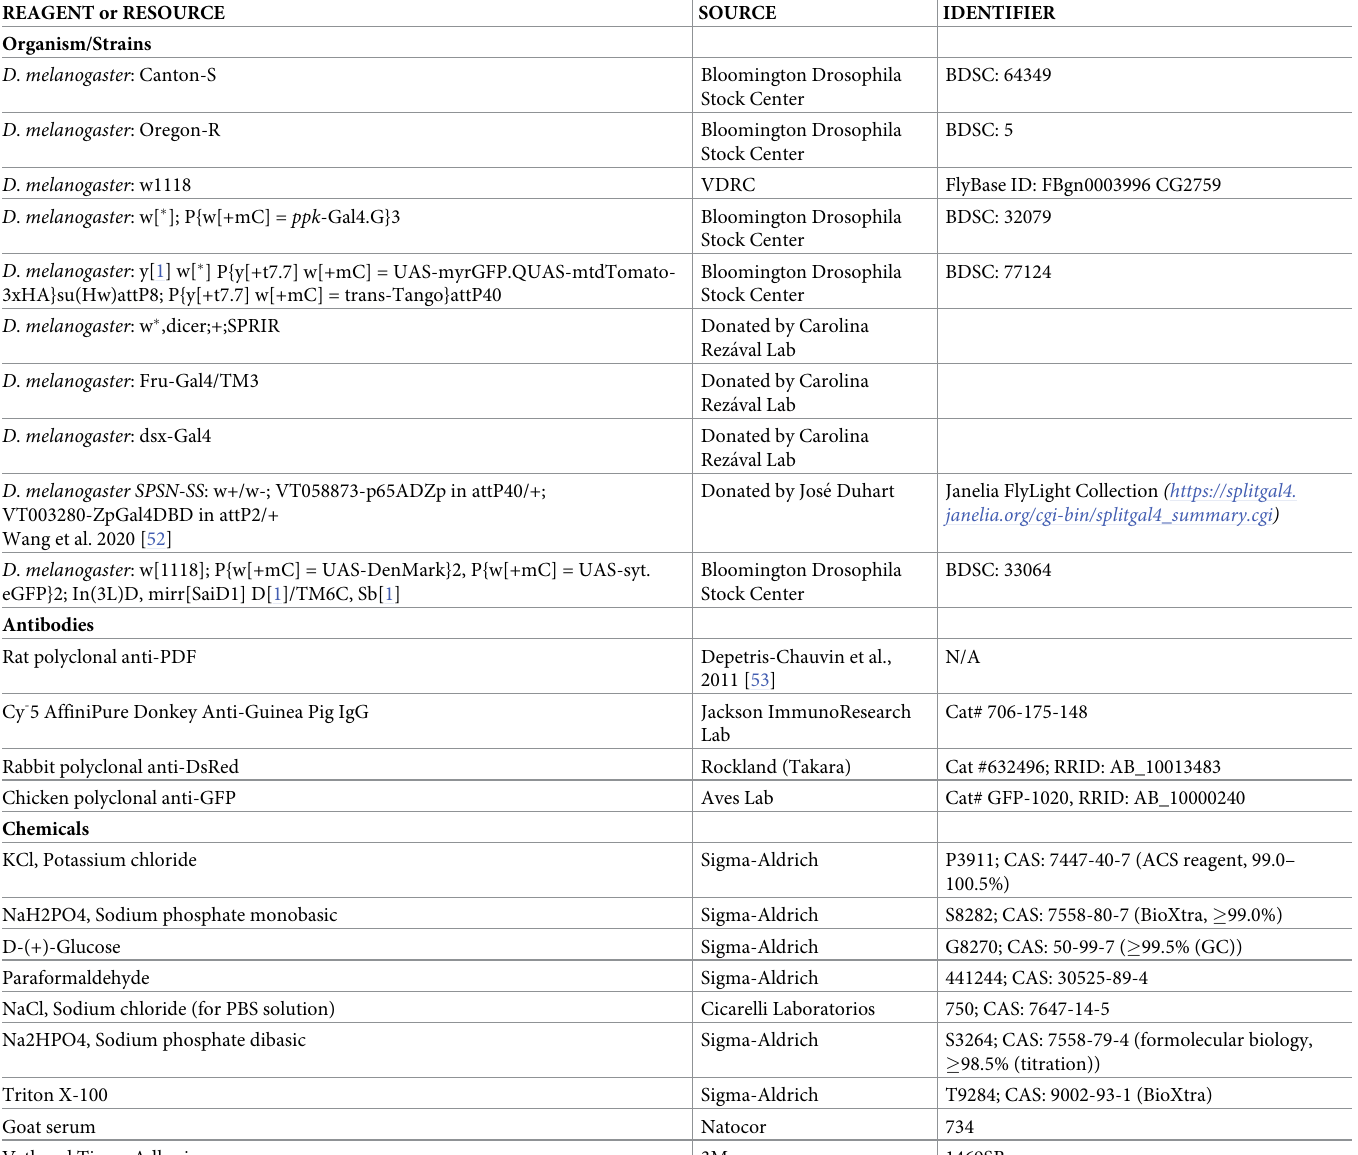
Table 1. List of fly stocks, chemicals and antibody used throughout this